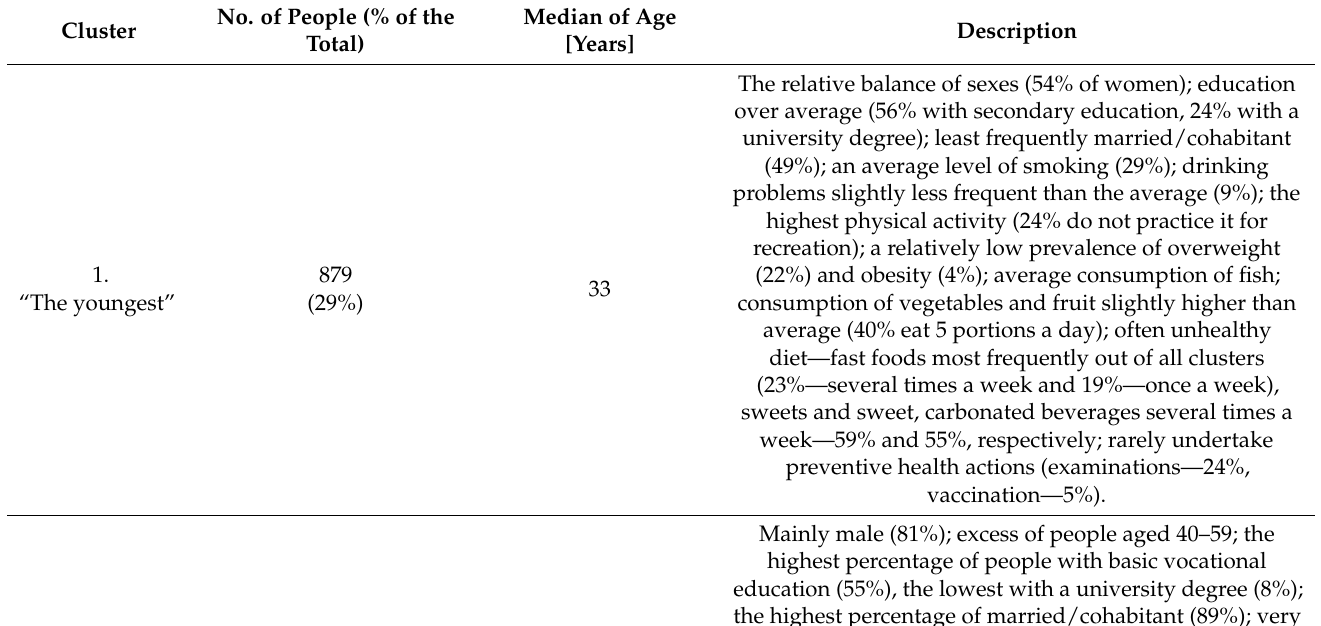
Table 2. Description of clusters identified according to the prevalence of behavioural health risk factors and socio-demographic characteristics in the Polish